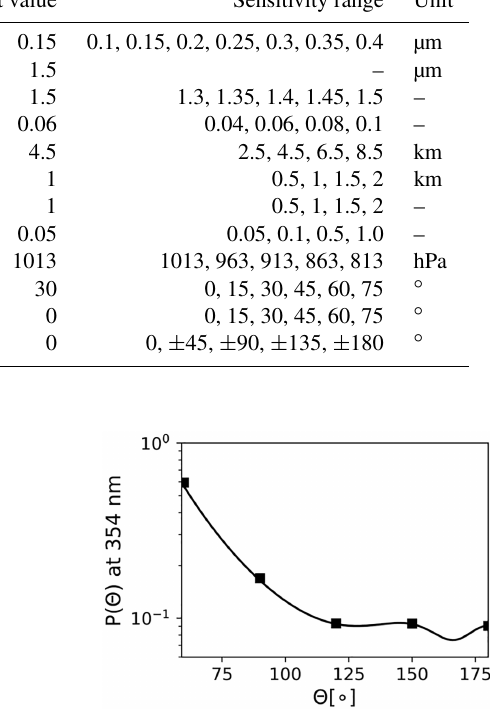
Figure 2. Phase function P((cid:50)) at 354nm of the parameterized Mie- scattering aerosol of default case ( r g = 0 . 15µm, n r = 1 . 5 and n i = 0 . 06) in sensitivity analysis. The markers in the plot correspond to the value when (cid:50) = 60, 90, 120, 150, 180 ◦